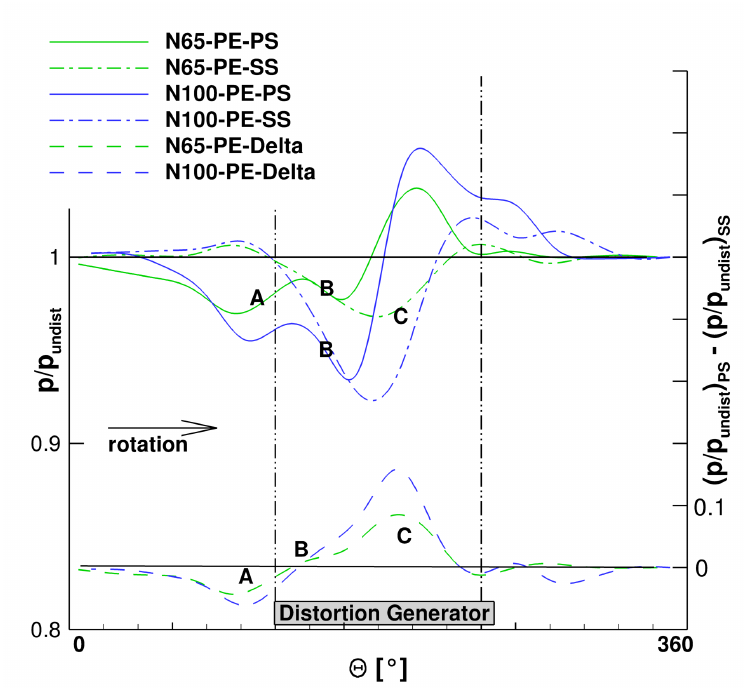
Figure 5. Normalized pressure on the blades averaged over 70% to 100% rel. blade height, Pressure Delta at peak efficiency (PE). PS: pressure side; SS: suction